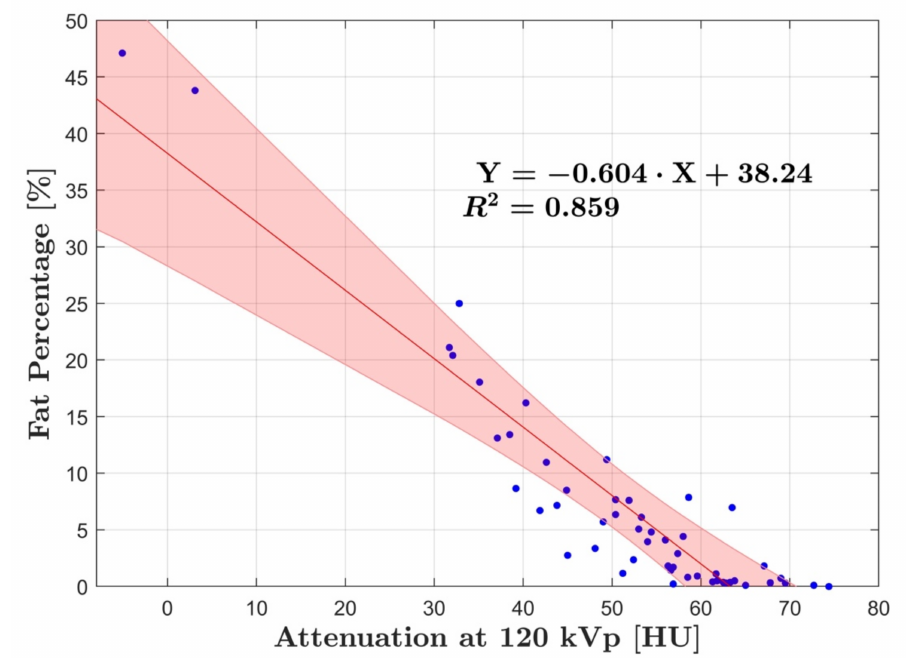
Figure 3. Linear regression analysis of group B showing the relationship between fat percentage and. HU at 120 kVp. Strong correlation was found R 2 = 0.86. The blue dots represent the average fat and HU measurements for each patient, while the red line corresponds to the line of best fit, with the red shaded area representing the 95%